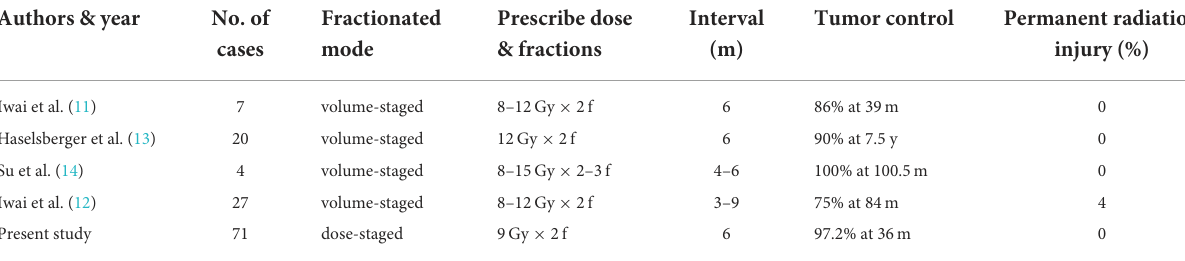
TABLE 4 List of studies regarding staged Gamma-Knife radiosurgery for